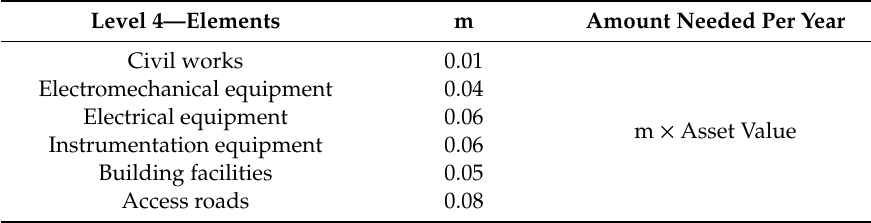
Table 6. Amount needed per